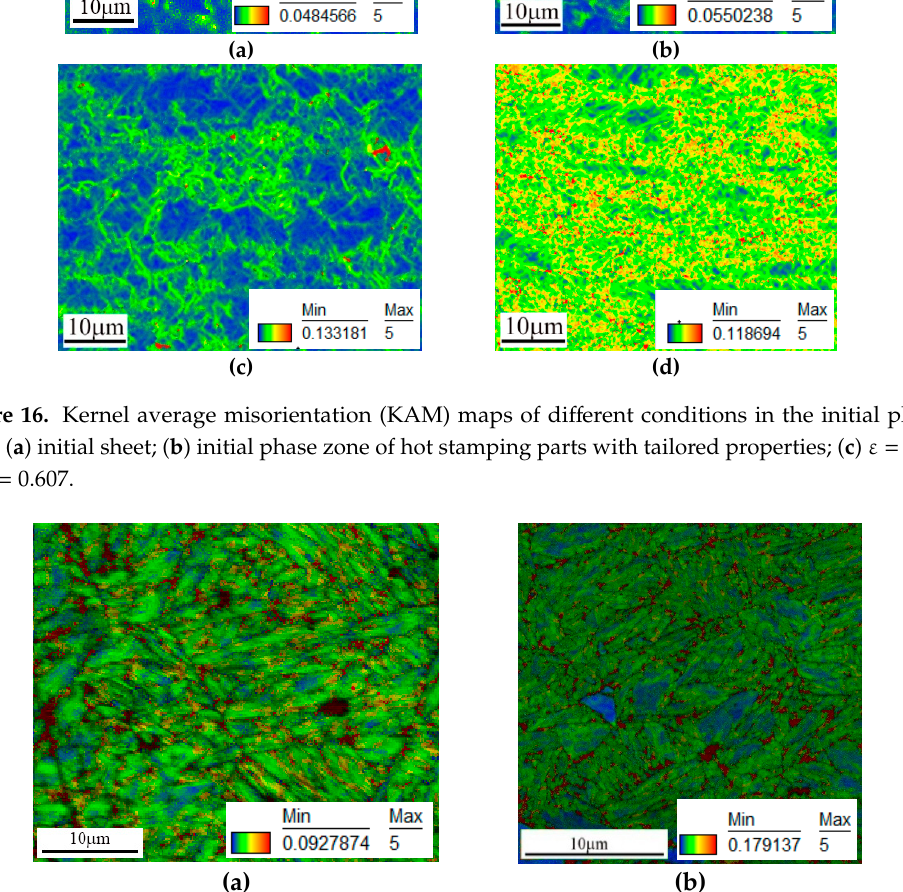
Figure 17. KAM maps of martensite phase zone undeform and fractured samples. ( a ) Martensite phase zone of hot-stamped parts with tailored properties; ( b ) martensite phase zone after fracture.